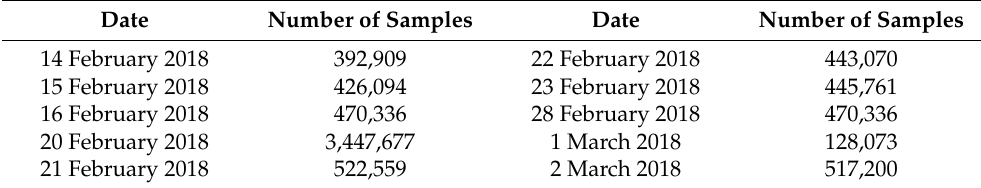
Table 4. Effective Sample Quantity Information After Data